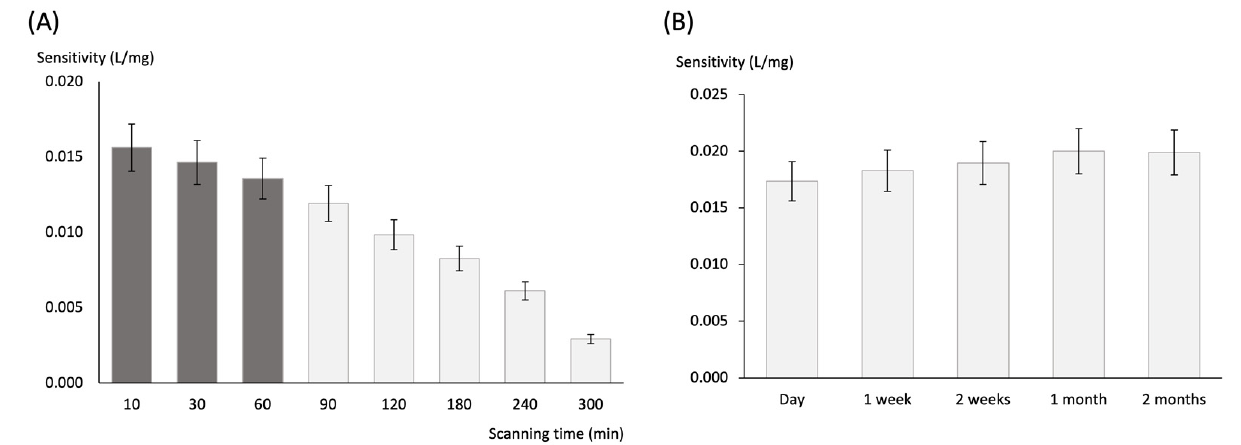
Figure 5. Stability assessment of the developed µ PAD for iron determination: ( A ) the colour reaction product with the recommended scanning times represented by the dark grey bars; ( B ) the device stability when stored in the dark at room temperature ( ≈ 21 ◦ C) in vacuum; the error bars represent 10% deviation of the measurements.